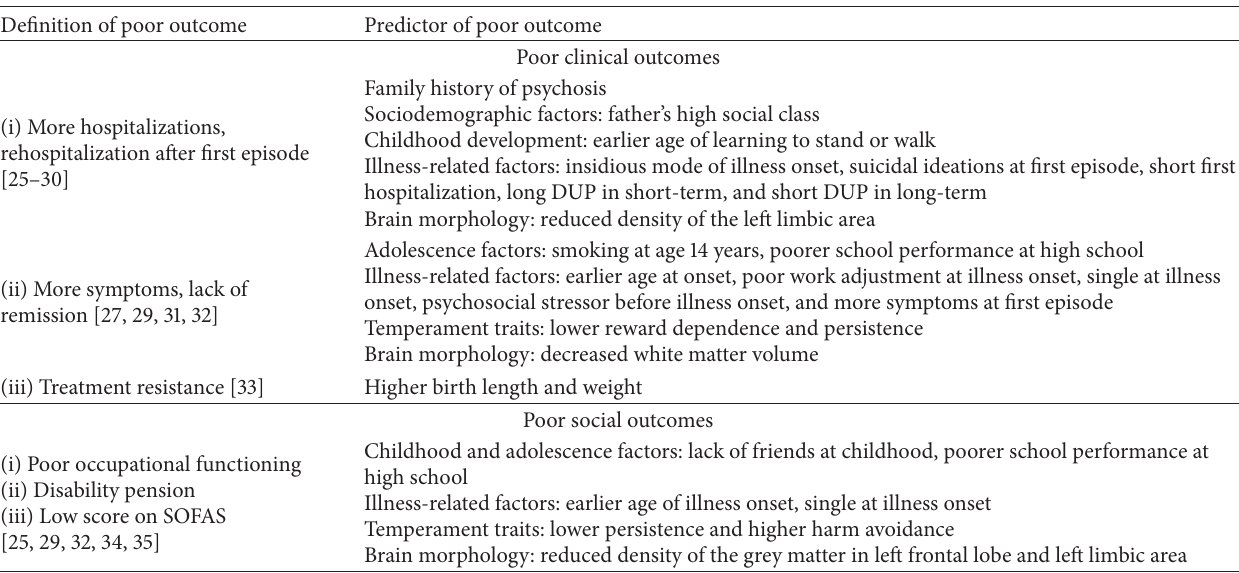
Table 2: Predictors of poor outcomes in schizophrenia in the Northern Finland Birth Cohort